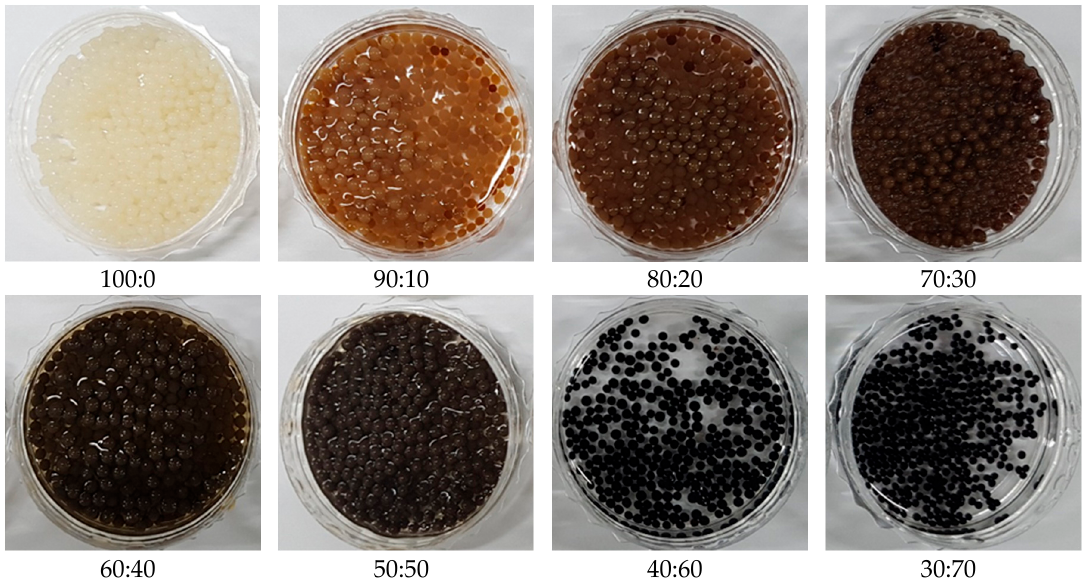
Figure 1. Photos of silk sericin (SS)/kraft lignin (KL) blend beads with various blend ratios.